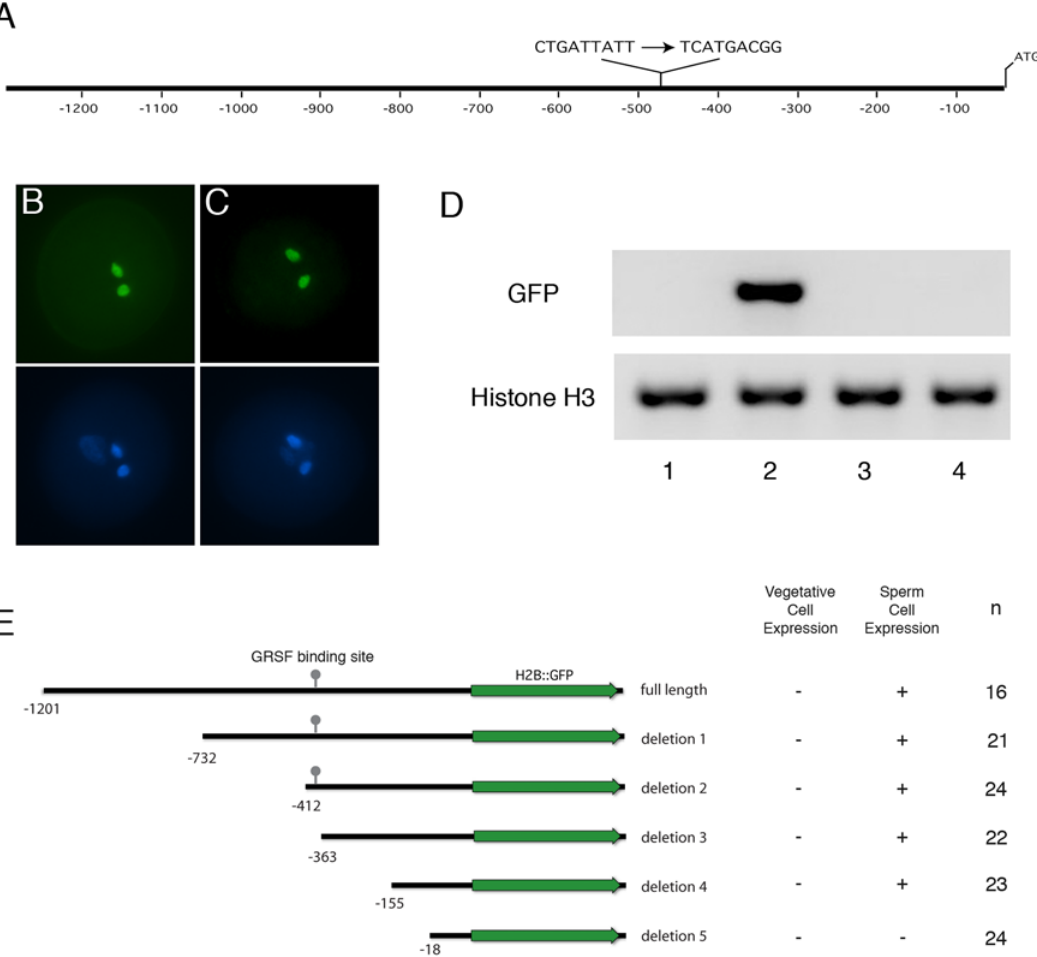
Figure 4. Male germline specificity of DUO1 does not depend on putative GRSF binding sites. (A) Schematic of the DUO1 promoter region illustrating the mutagenized putative GRSF binding site. (B,C) Expression of H2B::GFP in pollen driven by the native (B) or mutagenized DUO1 (C) promoters. Top panels show GFP signal, lower panels show DAPI staining. (D) RT-PCR analysis of native and mutagenized DUO1 promoter activity in seedlings. PCR was conducted on cDNA from wild type plants (1), control plants transformed with a constituitive HistoneH3 promoter-H2B::GFP fusion (2), and plants transformed with the native (3), or mutagenized (4), DUO1 promoters driving H2B::GFP expression. The primers used were specific for GFP (upper panel) or native Histone H3 transcripts (lower panel). The native or mutagenized DUO1 promoters showed no sporophytic expression of GFP transcripts. (E) Schematic representation of the of the DUO1 promoter 5 9 deletion series used to drive expression of H2B::GFP. The first four deletions, including deletion 3 in which the putative GRSF binding site is removed, showed a similar expression pattern to that of the full- length DUO1 promoter, with GFP signal only observed in sperm cell nuclei. The same expression pattern was observed in all independent lines examined (n). GFP expression was not observed in any transformants harbouring the shortest promoter fragment (deletion 5).